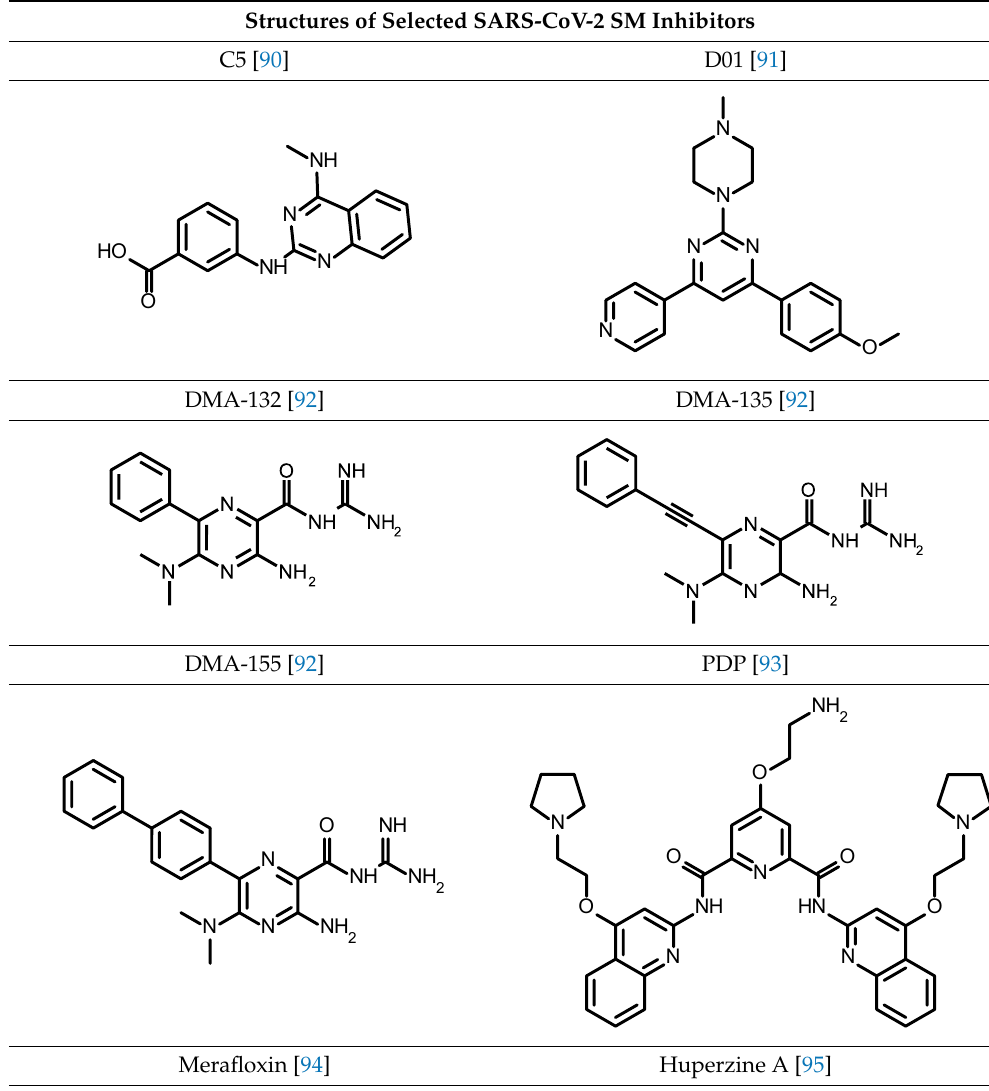
Table 2. Structures of most potent SARS-CoV-2 and IAV SM inhibitors.